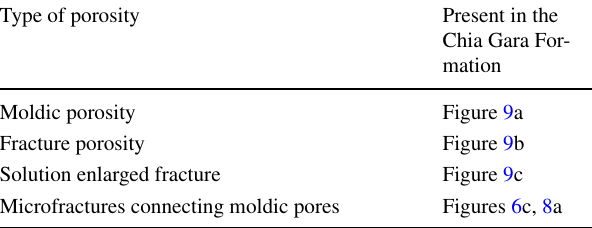
Table 4 Types of porosity in the Chia Gara Formation Type of porosity Present in the